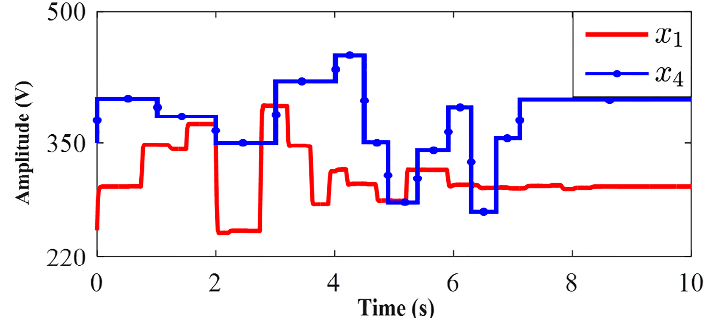
Figure 5. Voltage of C 1 and C 4 Capacitors in the presence of state-dependent Riccati equation (SDRE) controller.